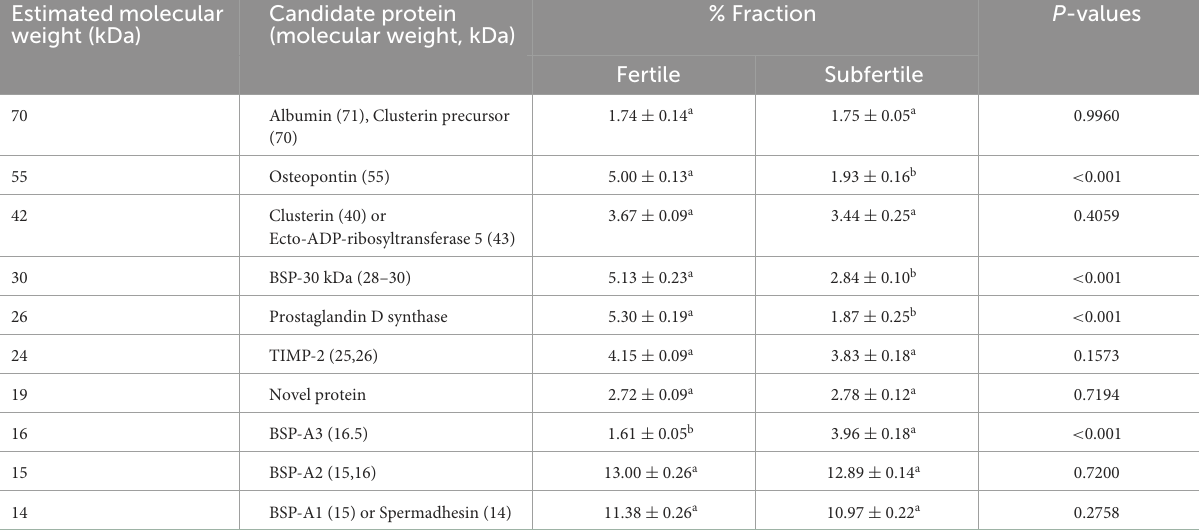
TABLE 4 Seminal plasma proteins profiles (kDa) and protein fractions (%) of fertile and subfertile buffalo bulls. Estimated molecular weight